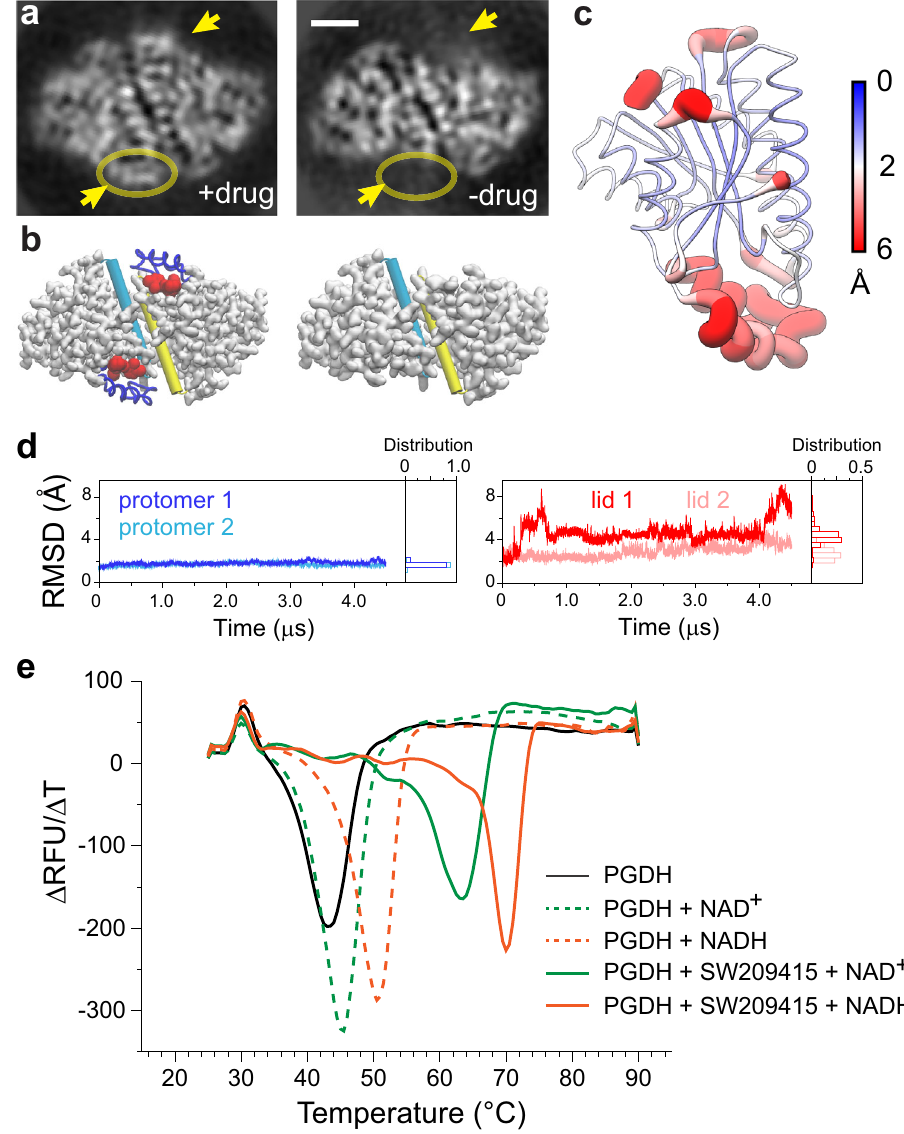
Fig.2|The15-PGDHdrug-bindinglidisdynamicanddisorderedintheabsence of inhibitor. a A comparison between the 2D class averages of human 15-PGDH with(left)andwithout(right)(+)-SW209415.Thepresenceorabsenceofdensityto account for the inhibitor and the drug binding lid are highlighted with yellow arrows. Scale baris20Å. b Structural illustration ofthe conformational changes in theabsenceofinhibitor(shownasredsphere).Theobviousconformationalchange is the loss of the drug binding clamp (shown as blue ribbon). The α 9 helices involved in dimer interface are shown as cylinder tube in cyan and yellow for individual subunits respectively. c Root mean square fl uctuation (RMSF) of C α atoms from a 4.5- μ s trajectory MD simulation of 15-PGDH without inhibitor. RMSF